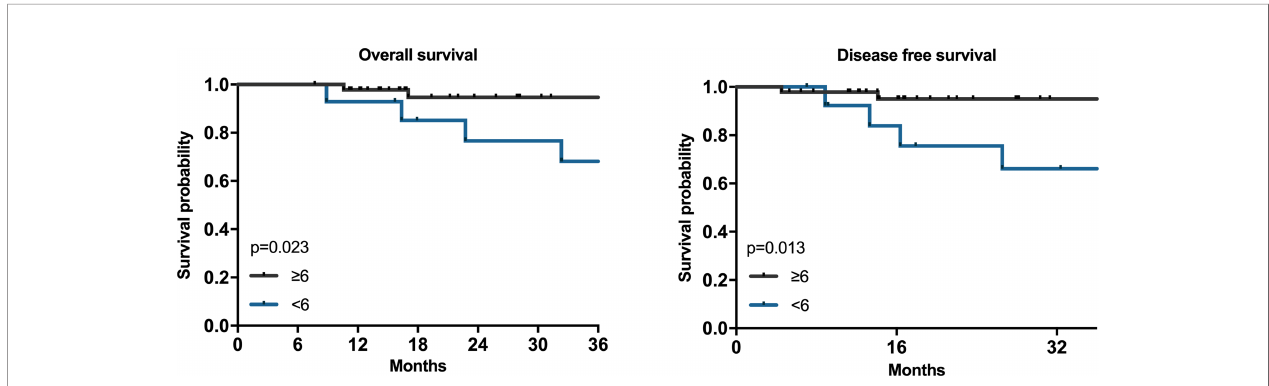
FIGURE 3 | The associations between adjuvant chemotherapy circles and prognosis of HAS. Kaplan – Meier survival plots for adjuvant chemotherapy cycles ≥ 6 and<6 for 61 patients. P values were calculated by the log-rank test.